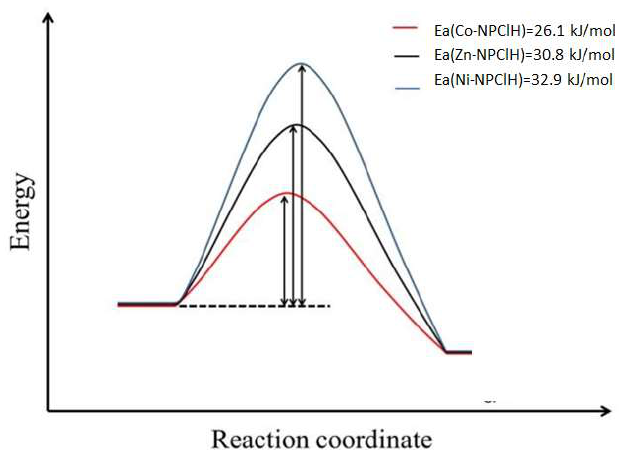
Figure 6. The activation energies ( E a ) for the cycloaddition of CO 2 and GIE catalyzed by M-NPClH.